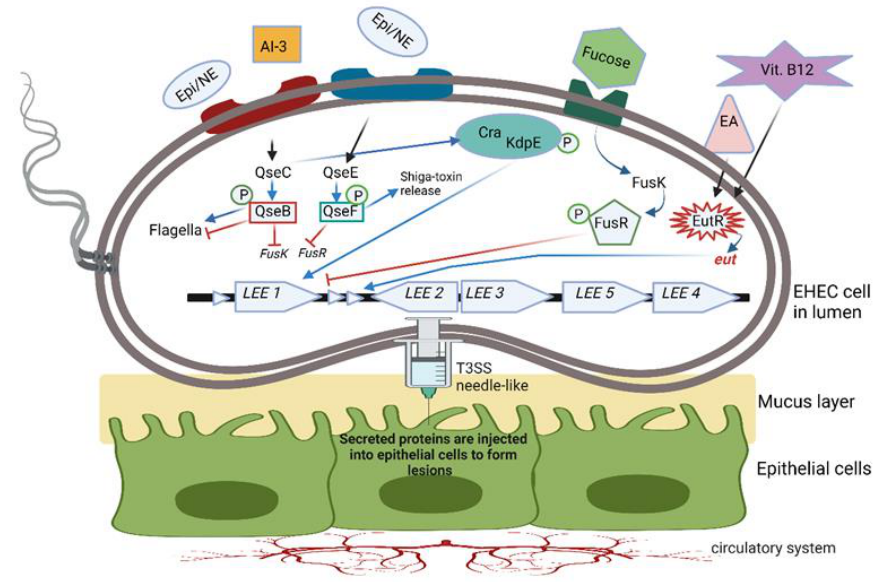
230 Figure 4. Two-component QS system (TCS) used by enterohemorrhagic E. coli (EHEC). Bacterial